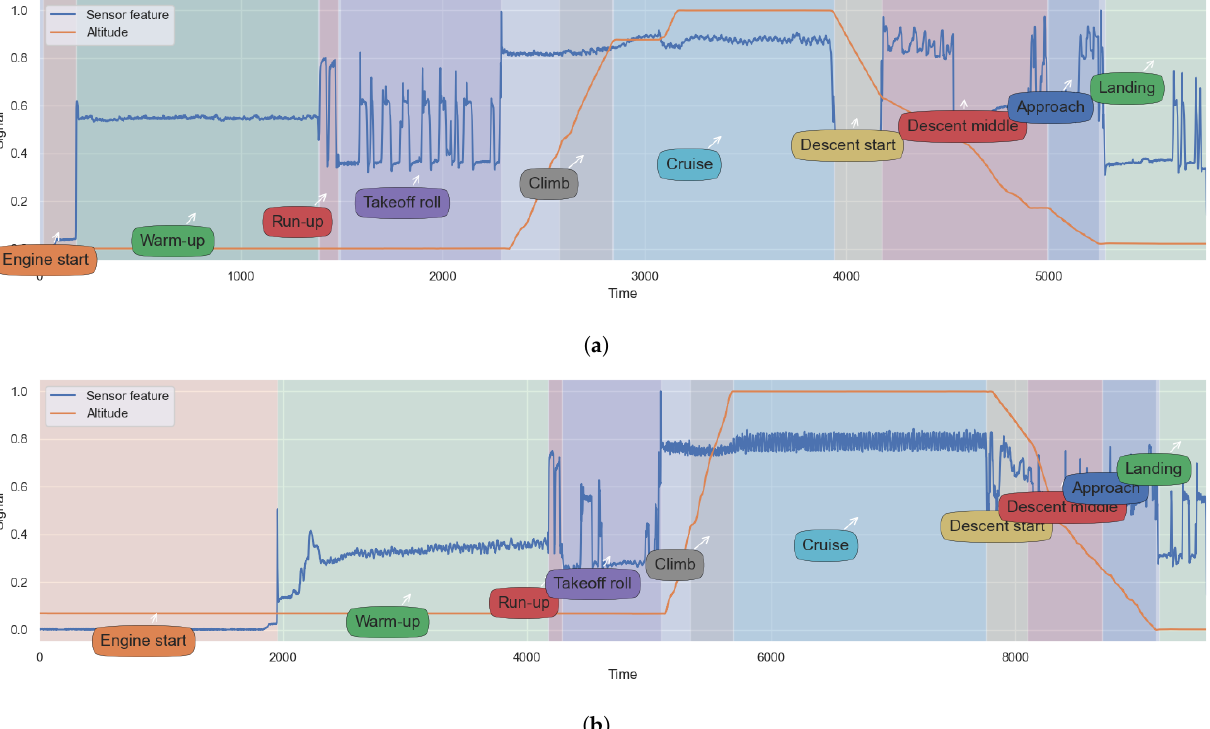
Figure 7. Operational regimes. The figure shows randomly selected flights and their operational regimes detected during the baselining. ( a ) Random flight #1; ( b ) Random flight